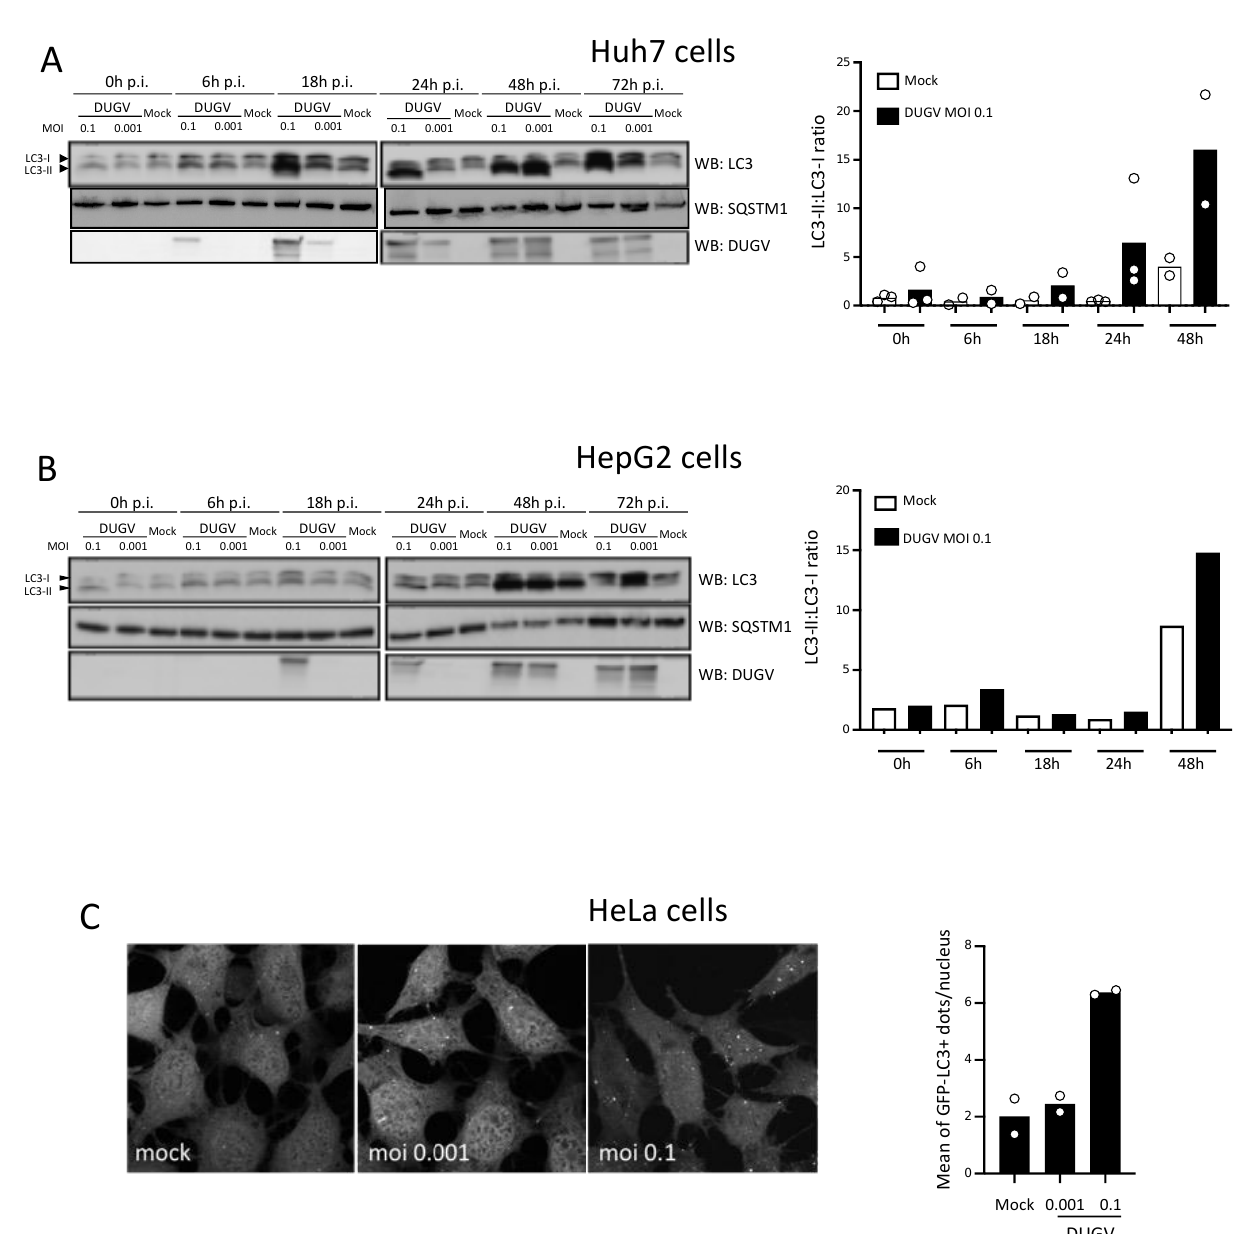
Figure 1. DUGV infection induces LC3 lipidation and biogenesis of LC3-positive punctiform struc- tures in cultured epithelial cells. ( A , B ) Huh7 ( A ) and HepG2 ( B ) cells were infected with DUGV at MOI 0.1 and 0.001 or treated with virus-free supernatant (Mock) and analyzed by Western blot for the expression of LC3 (17 and 15 KDa), SQSTM1/p62 (SQSTM1), and DUGV proteins (DUGV) at different time points after infection. Quantification in A represents the LC3-II:LC3-I ratio for Huh7 cells. Values are the mean of two (18 h, 48 h) or three (0 h, 6 h, 24 h) independent experiments (circles indicate values of independent experiments). Quantification in B represents the LC3-II:LC3-I ratio for HepG2 cells from a single experiment representative of two. In some instances, the LC3-II:LC3-I ratio was not derived as the massive LC3-II signal made the calculation uncertain. ( C ) Confocal microscopy analysis of HeLa cells stably expressing a GFP-LC3 reporter construct 48 h after DUGV infection (MOI 0.1 and 0.001). GFP-LC3 puncta were quantified on plan sections. Results compiled from two independent experiments are expressed as the number of puncta per nucleated cell. At least 400 cells were examined for each condition (circles indicate values of independent experiments). Representative images from confocal microscopy are